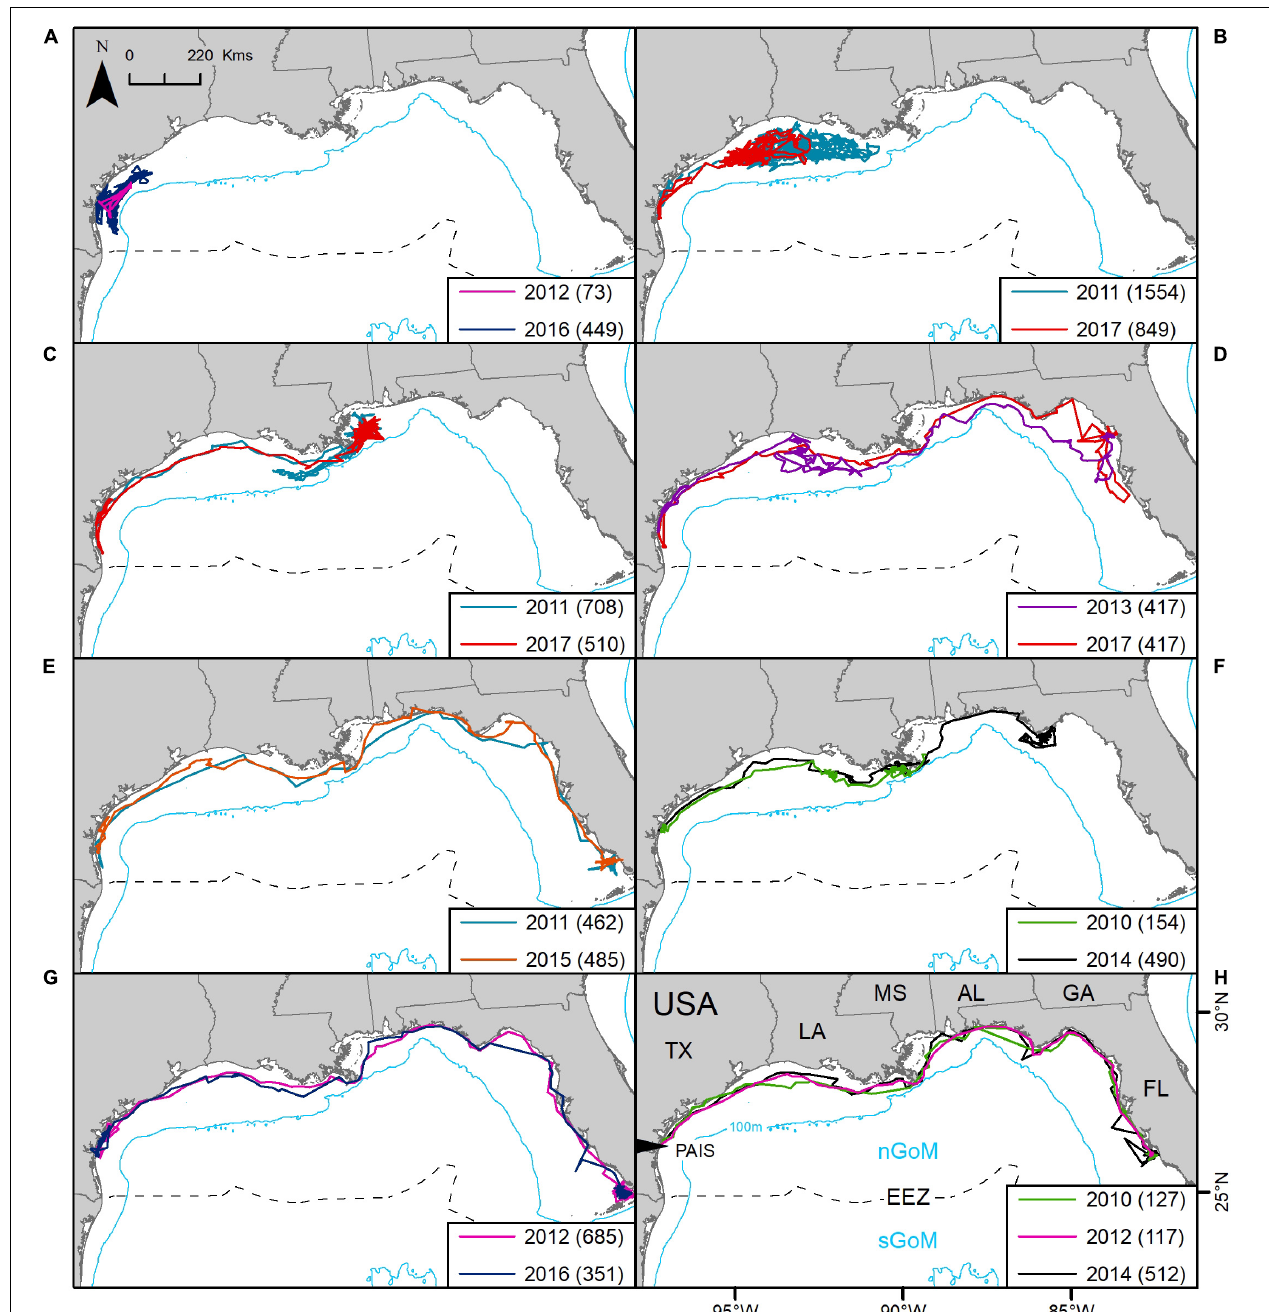
FIGURE 5 | Repeat tracking of eight post-nesting female Kemp’s ridley sea turtles in the northern Gulf of Mexico tracked from Padre Island National Seashore, Texas, United States (PAIS): (A) platform terminal transmitters (PTTs) 117515 and 152803; (B) PTTs 101137 and 152828; (C) PTTs 101138 and 152827; (D) PTTs 112763 and 152829; (E) PTTs 106343 and 141781; (F) PTTs 47562 and 133286; (G) PTTs 112758 and 152802; (H) PTTs 47524, 112762 and 133285. The Exclusive Economic Zone (EEZ) demarcates the division between the northern Gulf of Mexico (nGoM) and southern Gulf of Mexico (sGoM). Numbers in parentheses equal the number of tracking days for each deployment. Tracks were reconstructed from mean daily locations of filtered location data. Transmitters were deployed between 2010 and 2017.